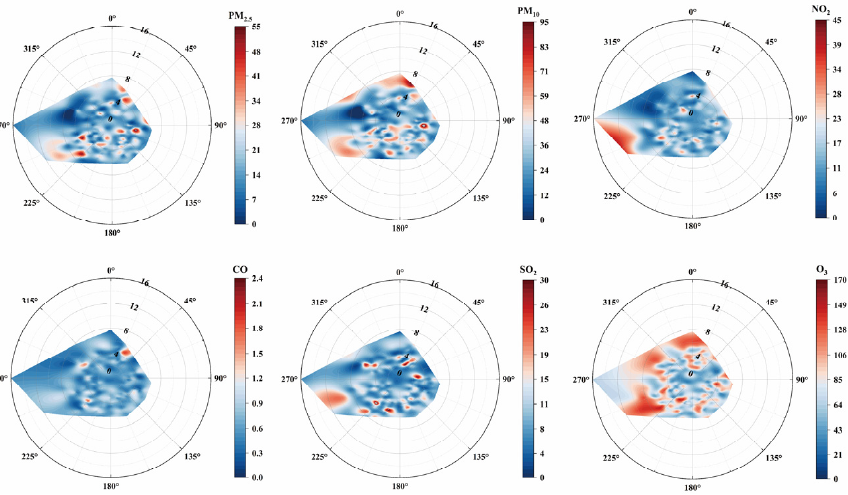
Figure 9. Polar plots of mean concentrations of main pollutant concentrations in the wet season.